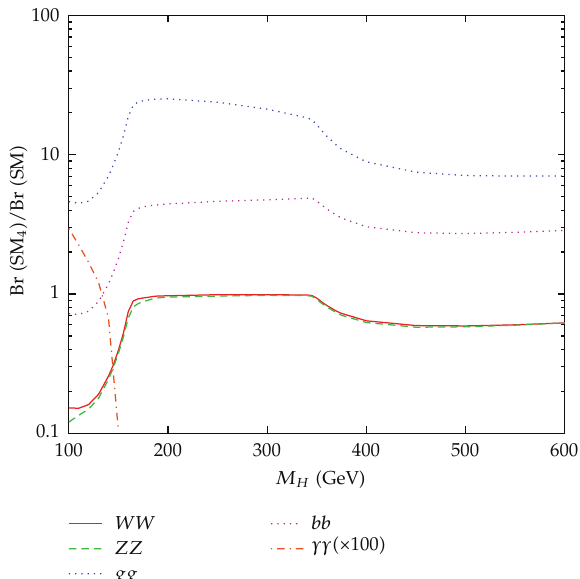
Figure 6: Comparison of Higgs decay rates within the SM4 and the standard model including NLO-electroweak corrections. In particular interesting is the strong reduction of the 𝐻 → 𝛾𝛾 channel. Figure from